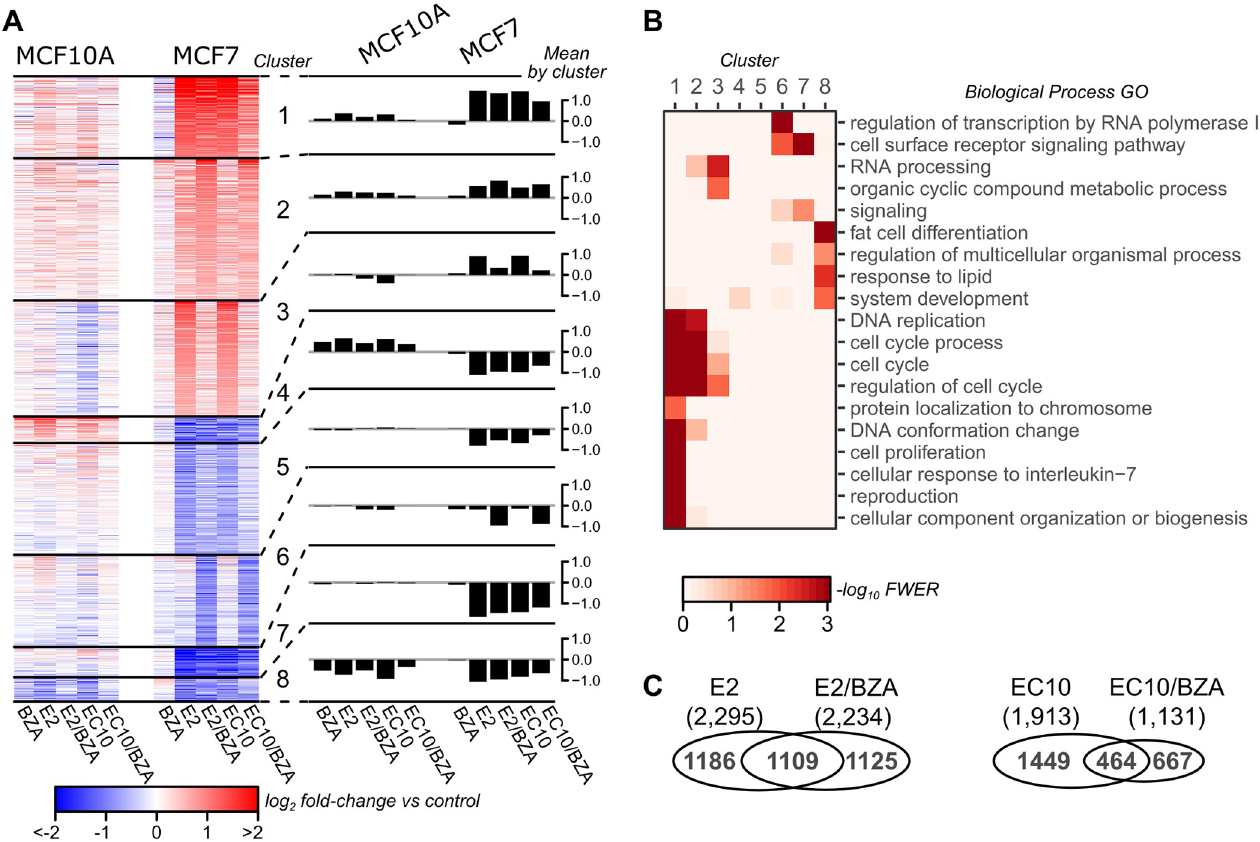
Fig 1. Gene expression changes with SERM/SERD treatments (bazedoxifene–BZA) in MCF10A and MCF7 cell lines, as evaluated by RNA-seq. A) Clustering of 3,820 differentially expressed genes. Values are average log2 fold change (FC) of normalized counts in 3 independent replicates relative to the untreated control for each cell line. Eight clusters were calculated using k-means. Data for individual genes are presented in the left panel heatmap, and mean values (log2 fold-change) in each cluster are presented in the right panel barplots. B) Biological process gene ontology (GO) enrichment per cluster. Terms shown are the least redundant terms as determined by REViGO. C) Venn diagram comparing differentially expressed genes in MCF7 between E2 vs E2/BZA (left) and EC10 versus EC10/BZA (right); each of the 4 groups are relative to